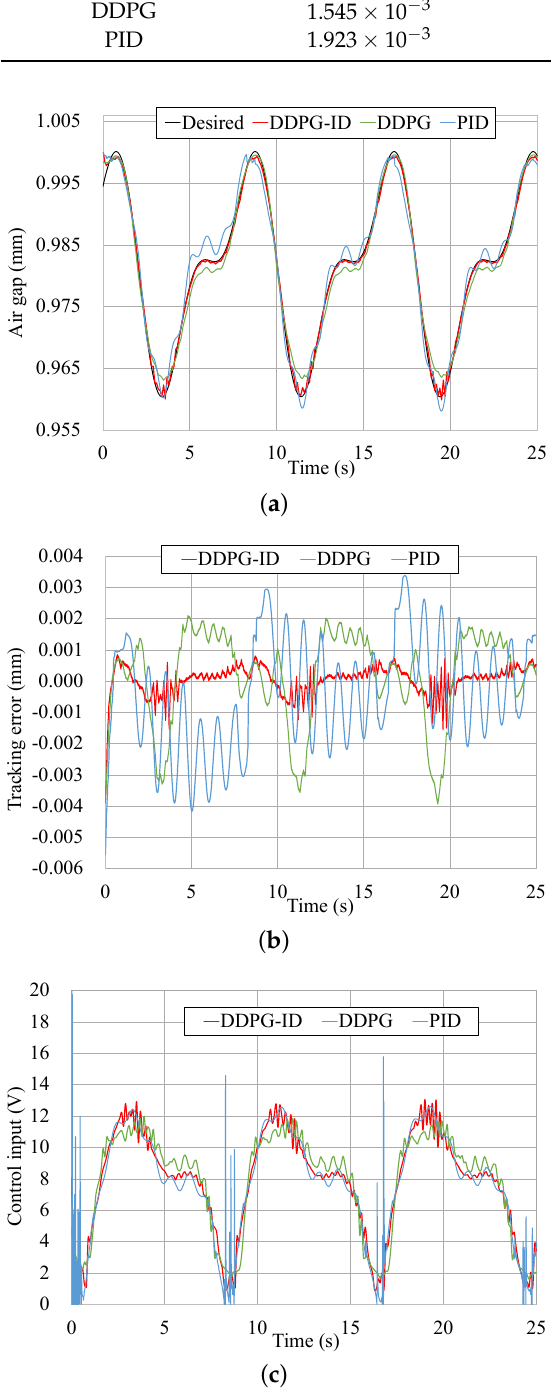
Figure 10. Tracking results comparison of the periodic trajectory. ( a ) Tracking results comparison based on three control schemes. ( b ) Tracking error comparison based on three control schemes. ( c ) Control input comparison based on three control